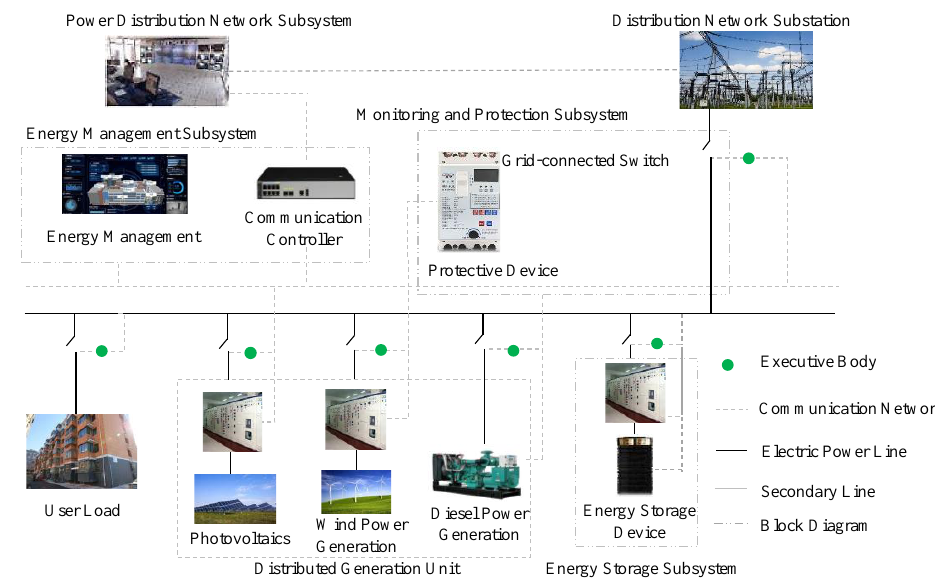
Figure 1. Sketch map of smart